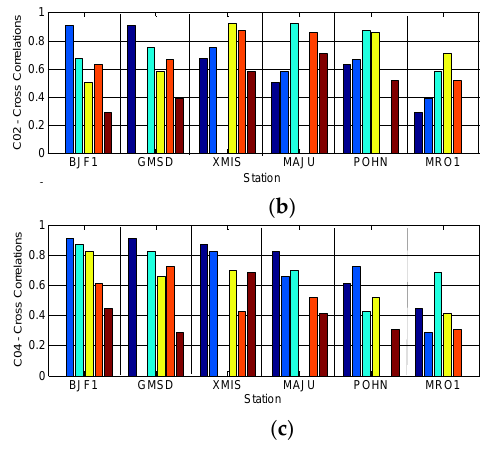
Figure 8. The Spearman cross-correlations between multipath biases at different stations for satellites C01 ( a ); C02 ( b ) and C04 ( c ).